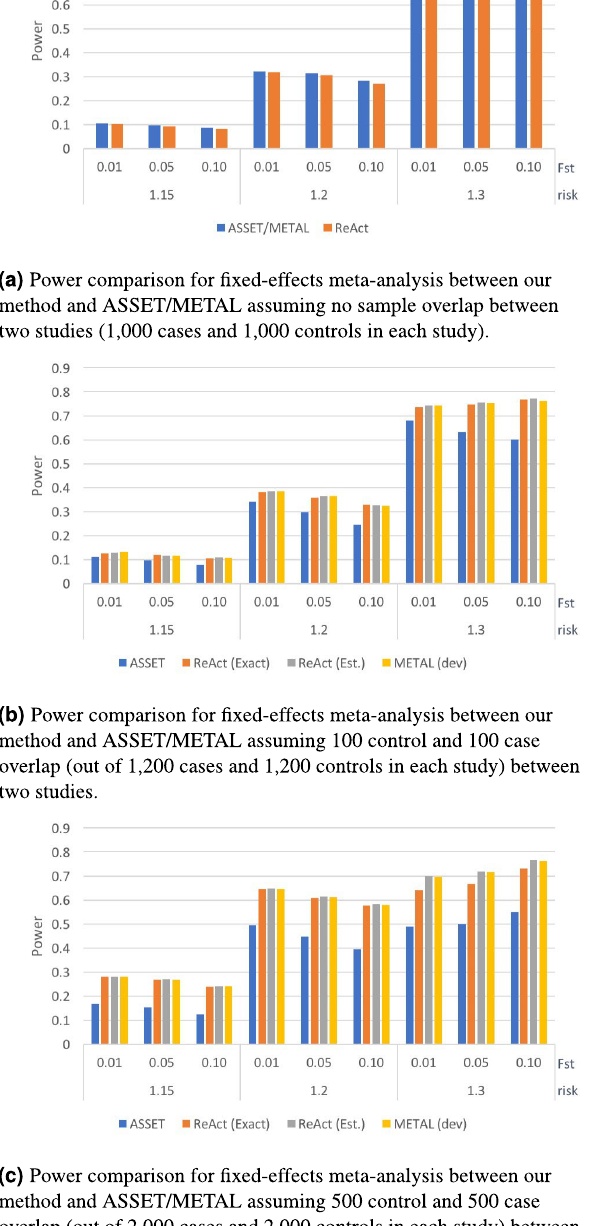
Figure 1. Power of fixed-effect meta-analysis with two input studies under different conditions. We compare the power of our method vs. ASSET/METAL for a significance threshold p < 5